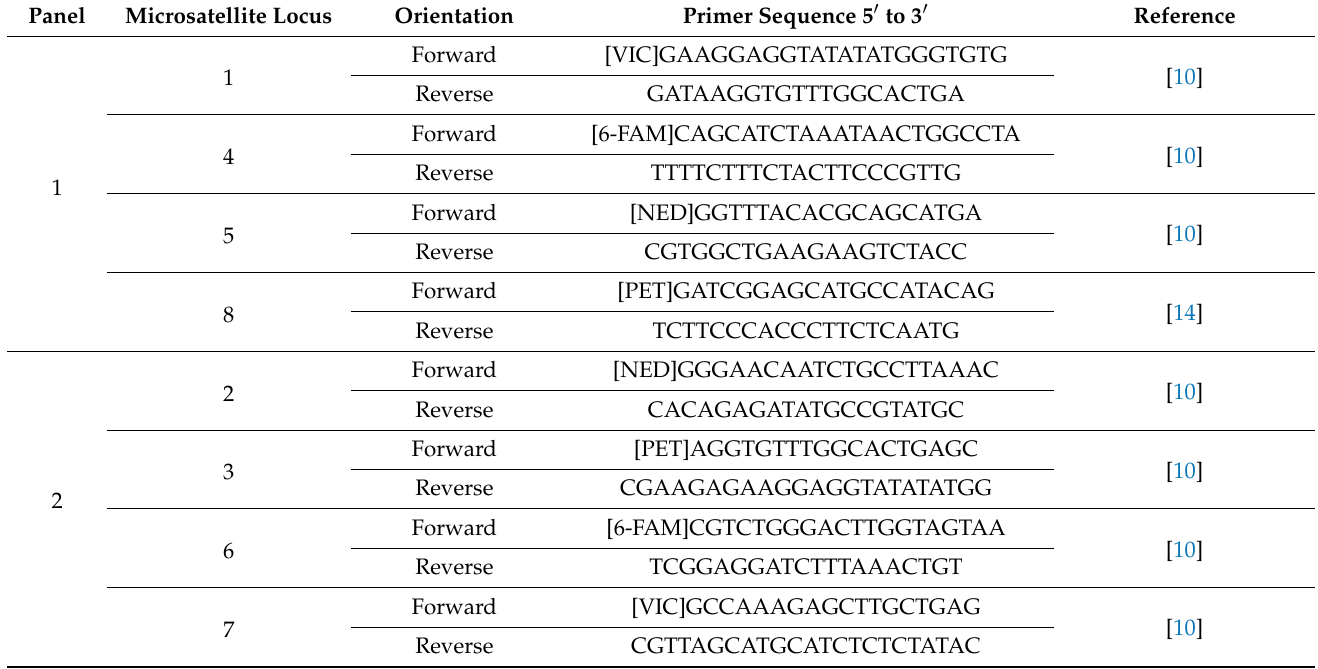
Table 1. Primer sequences with corresponding fluorescent dyes (6-FAM, VIC, NED, and PET) used for the microsatellite